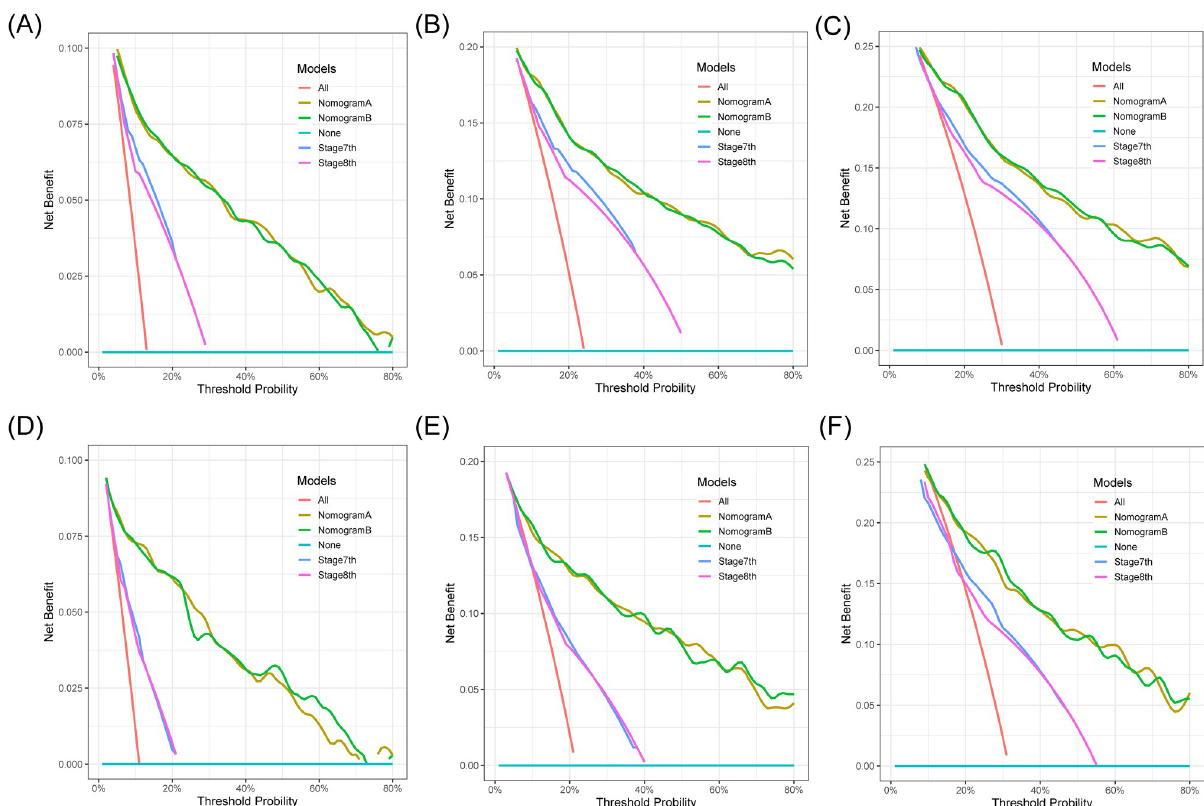
Fig 4. Decision curve analysis for the 1- (A), 3- (B), and 5- (C) year OS rates of patients with NF-pNET in training cohort. Decision curve analysis for the 1- (D), 3- (E), and 5- (F) year OS rates of patients with NF-pNET in validation cohort.